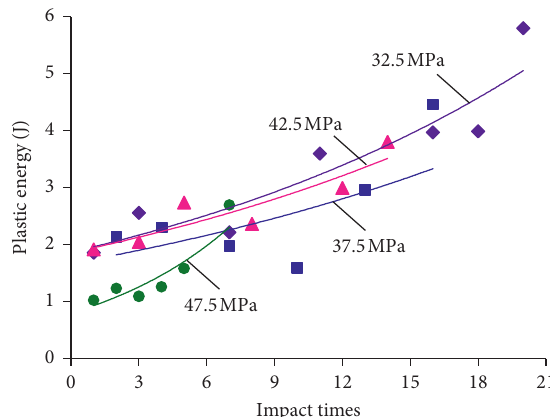
Figure 10: Relationship between the plastic energy accompanying with impact and impact times (the numbers in figure represents the axial static stress of specimen during impact).